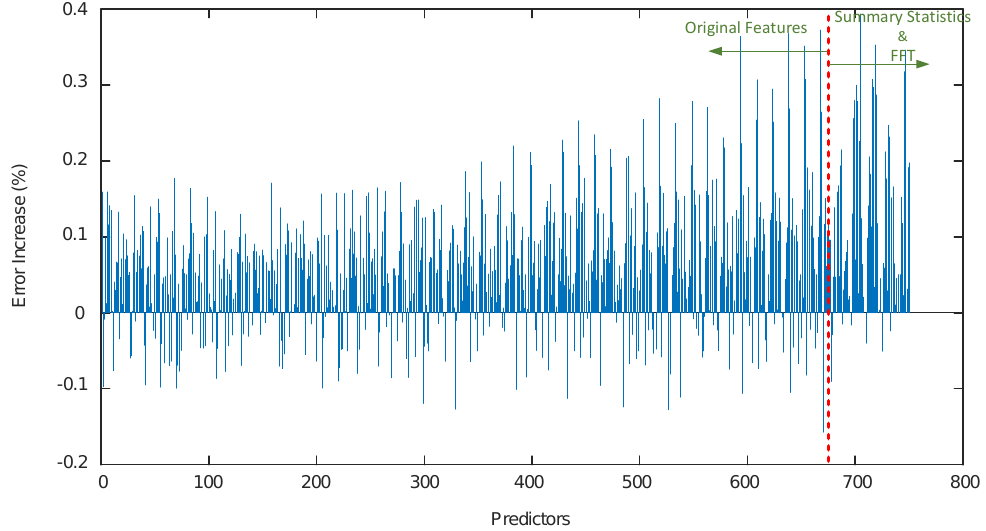
Figure 1. Random forest misclassification error increase after predictor random permutation.